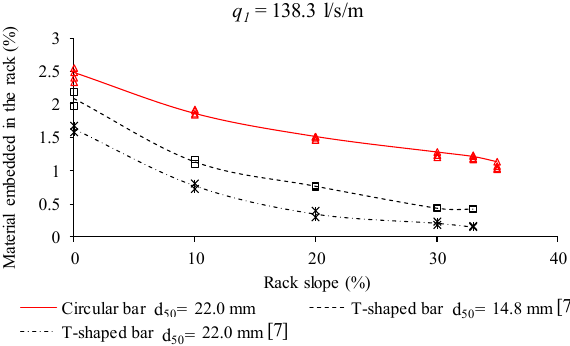
Figure 18. Comparison of effective void ratio, m ′ , for circular bars and values previously presented for T-shaped bars [7].